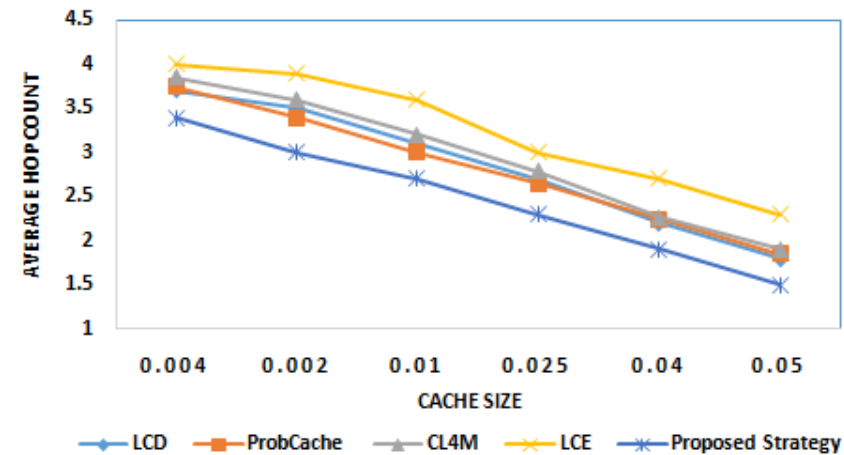
Figure 6. Average hop count for different cache sizes.